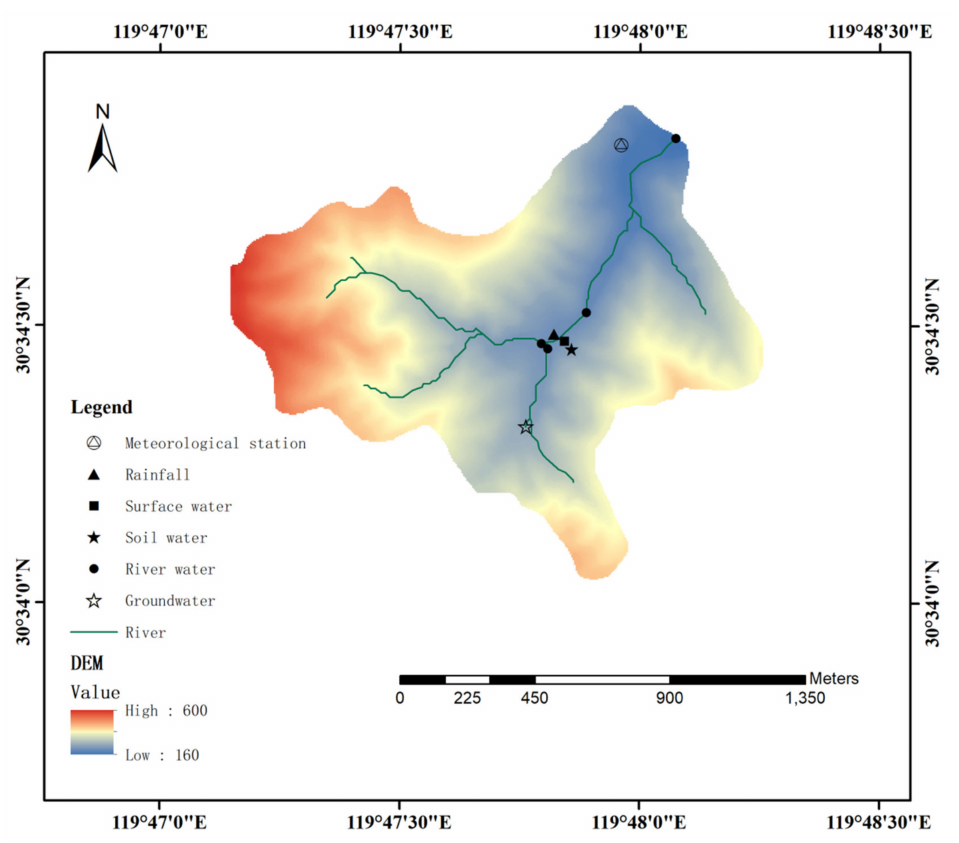
Figure 1. Location of the Hemuqiao catchment and sampling sites for different water